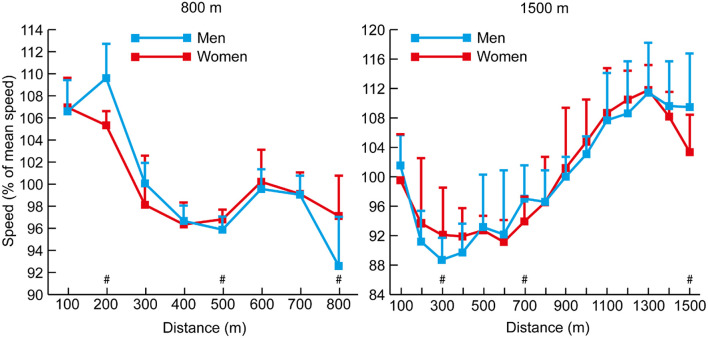
The mean (+ SD) section speed expressed as a percentage of mean speed for all men and women in the 800 and 1,500 m events. Differences in segment speed percentage between men and women (p < 0.05, d ≥ 0.61) have been annotated (#).